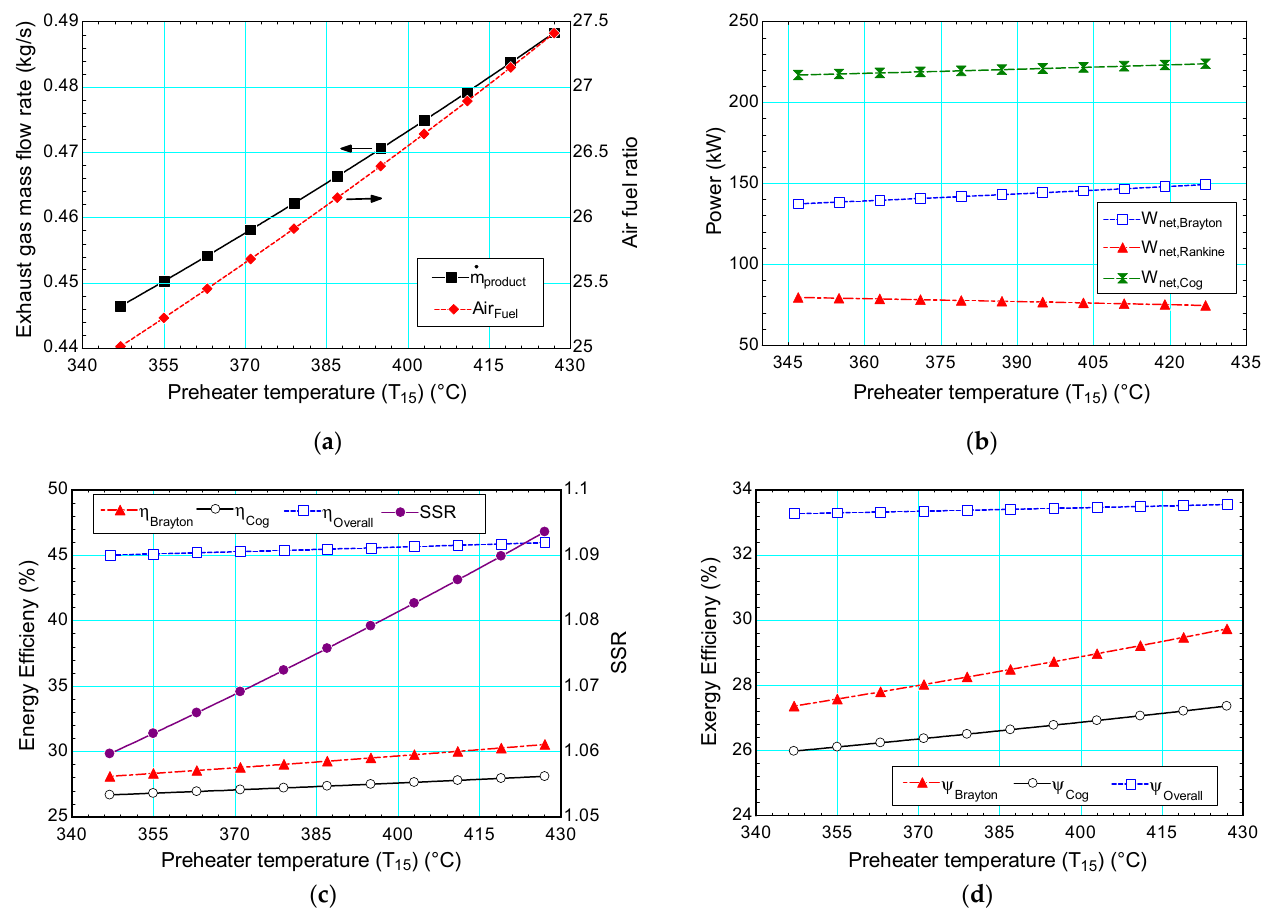
Figure 9. Combustor inlet temperature effect on: ( a ) air fuel ratio and exhaust gas mass flow rate, ( b ) power production, and self-sufficiency ratio (total required power for the WWTP is 184.3 kW), ( c ) Energy Efficiency, ( d ) Exergy Efficiency.